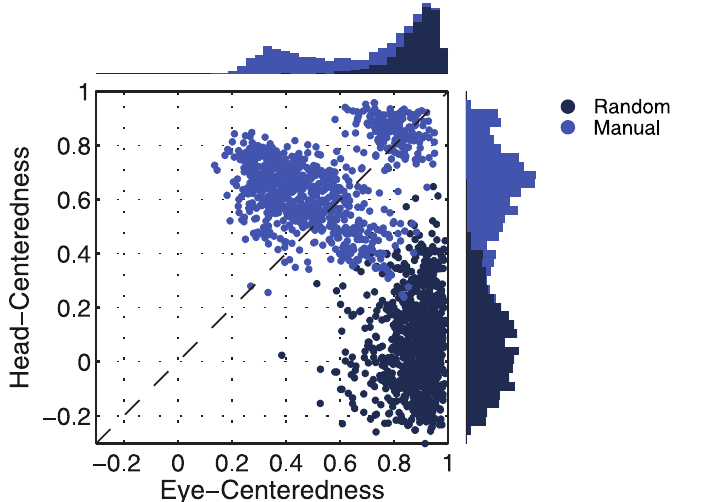
Fig 9. Performance of the prewired network model with monotonic modulated input neurons. The Figure shows the performance of the network model that has been manually prewired to produce head-centred output neurons with input neurons that are modulated by a sigmoidal function of eye-position. The scatter plot shows the eye-centredness and head-centredness values of all output neurons from the manually prewired model and a randomly wired model. Same conventions as in Fig 5. It can be seen that the majority of the output neurons in the manually prewired model display head-centred